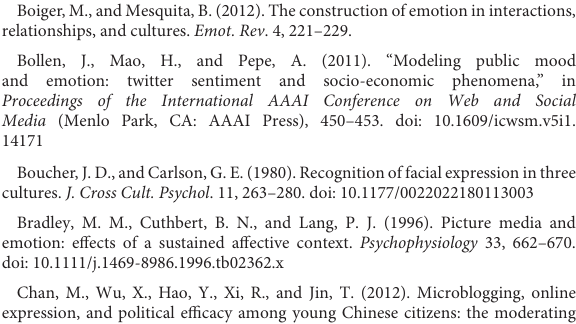
TABLE 8 Vector auto-regressive model ( p = 1) between emotions and fund performance of the China Merchants Liquor Index Fund. IV DV Estimate Unit net